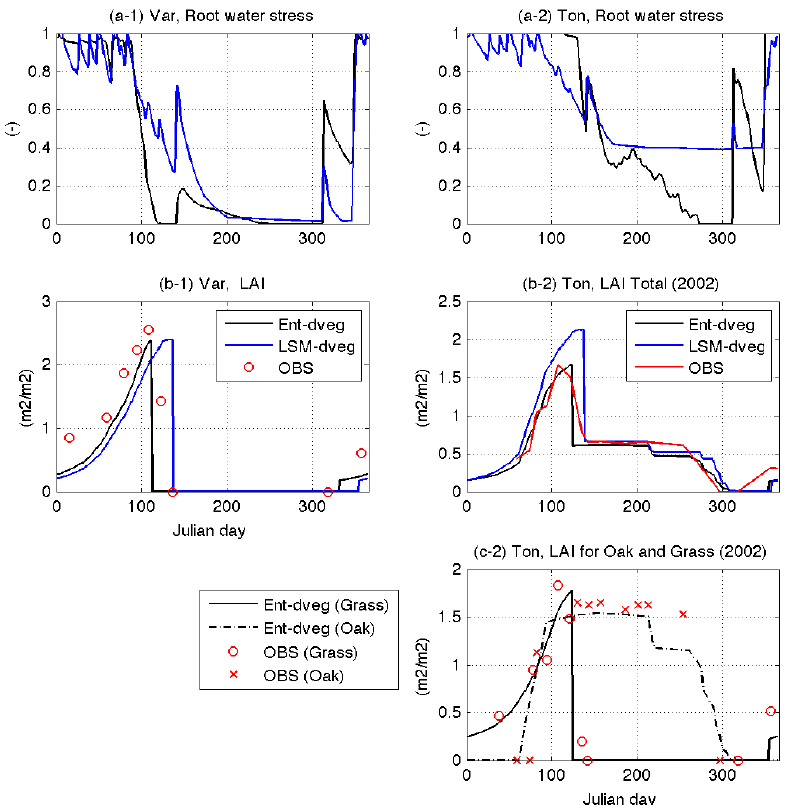
Figure 6. (a) Daily root water stress and (b – c) daily LAI in the Vaira and Tonzi ranches for